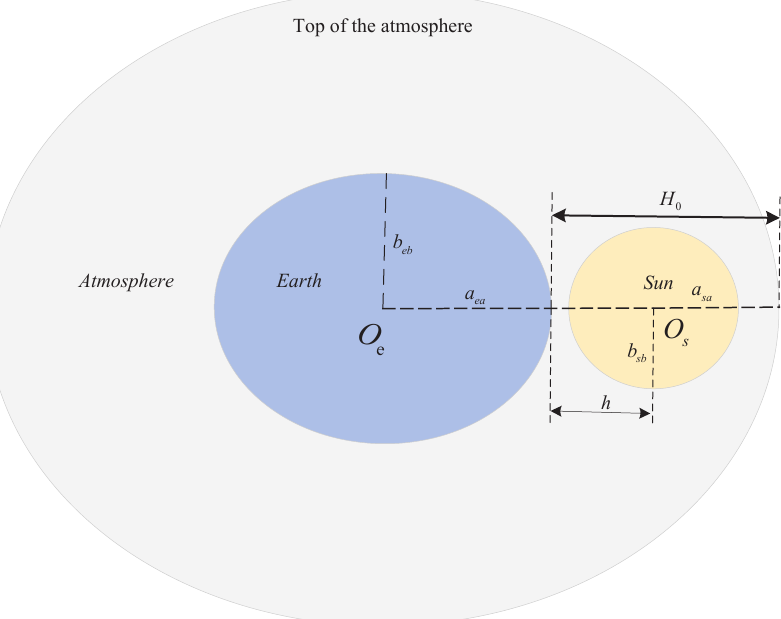
Figure 3. The model considering the atmosphere and oblateness of the Earth and the